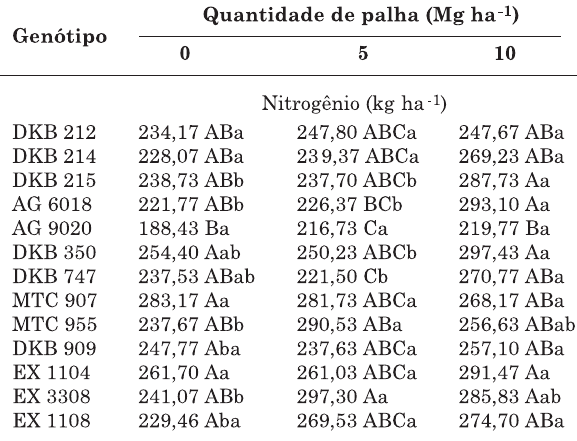
(Figura 4). Isso se explica pela imobilização do N